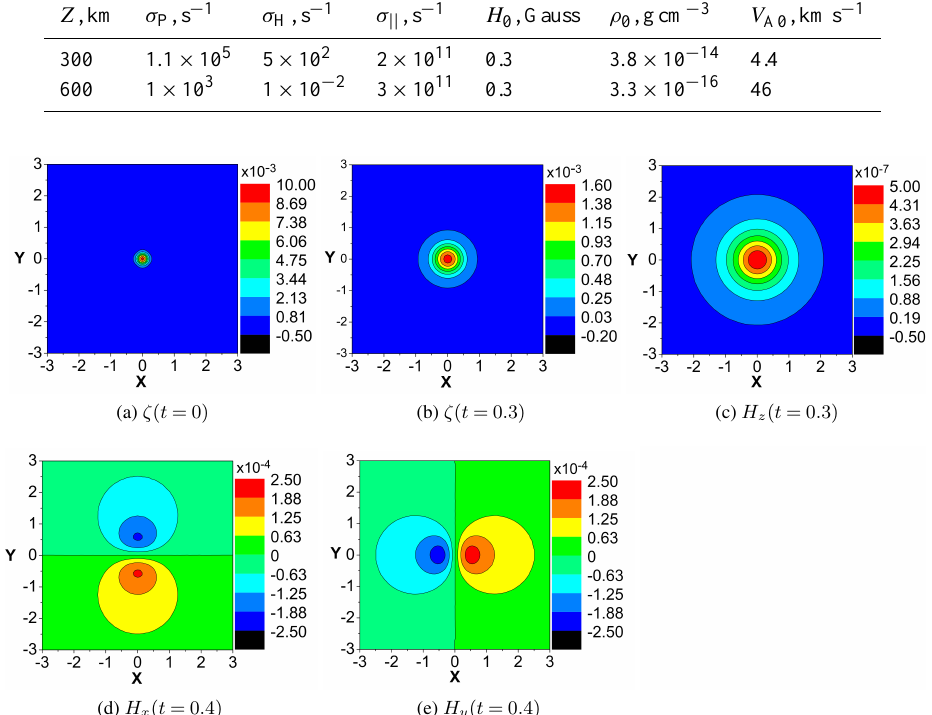
Table 1. The ionosphere night-time parameters.